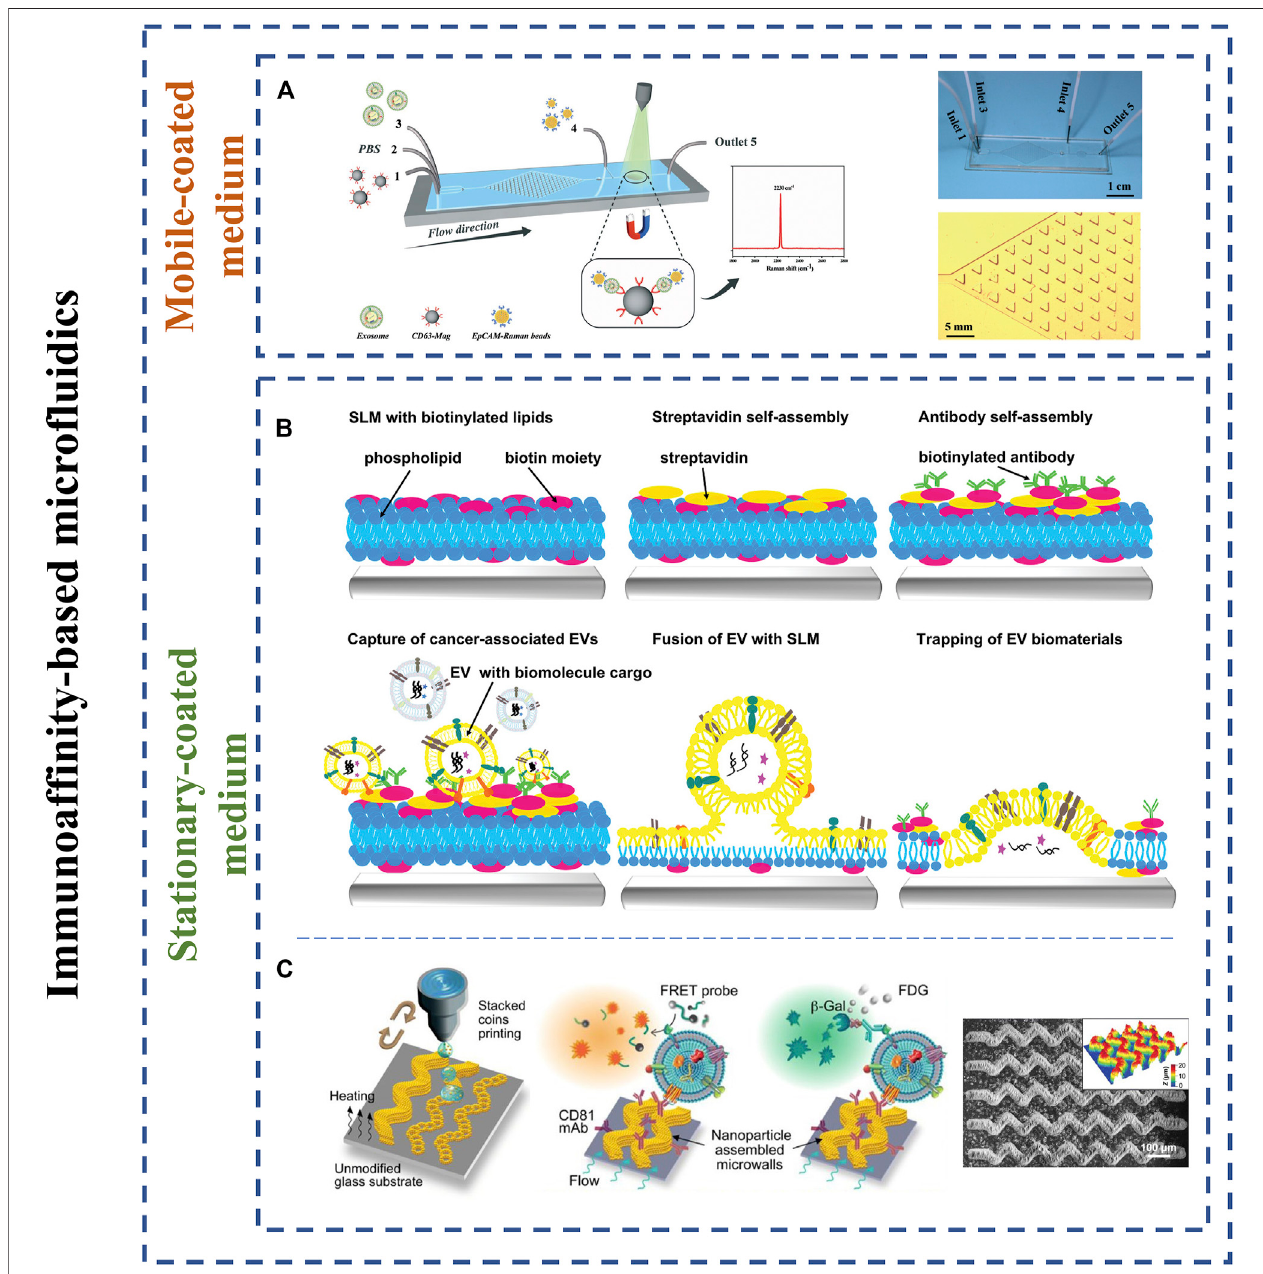
FIGURE7| Schemeofimmunoaf fi nity-basedmicro fl uidicsforexosomeisolationandenrichment. (A) Micro fl uidicRamanchipforexosomeisolationanddetection. Adapted from(Wangetal.,2020),copyright2020RoyalSocietyofChemistry. (B) Schemeoflipidmembranesmicroarraysfunctionalizedwithantibodies. Adapted from (LiuH.Y.etal.,2021),copyright2021Wiley-VCHVerlagGmbH&Co. (C) 3DnanopatternedEV-CLUEchipweremanufacturedbycolloidalinkjetprinting.Adaptedfrom (Zhang et al., 2020), copyright 2020 American Association for the Advancement of Science.